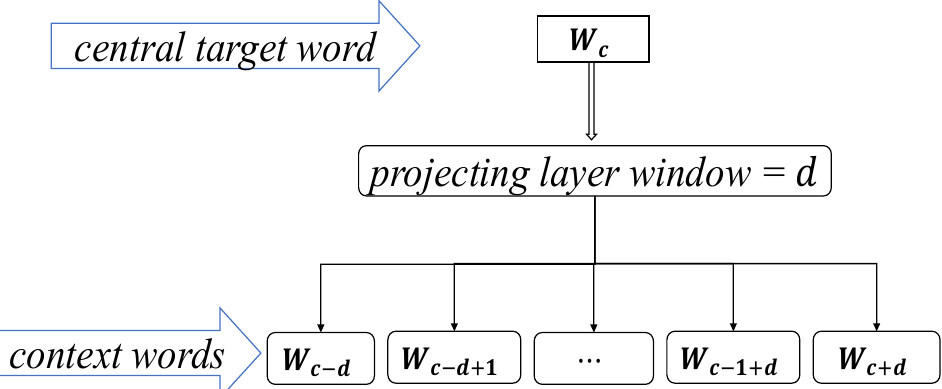
Figure 3. The structure diagram of Skip-gram model.